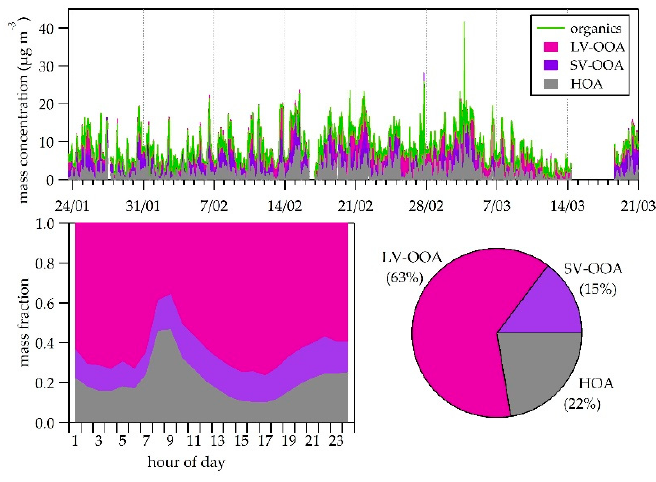
Figure 10. Time series, diurnal profiles, and percent of total organic mass of PMF organic